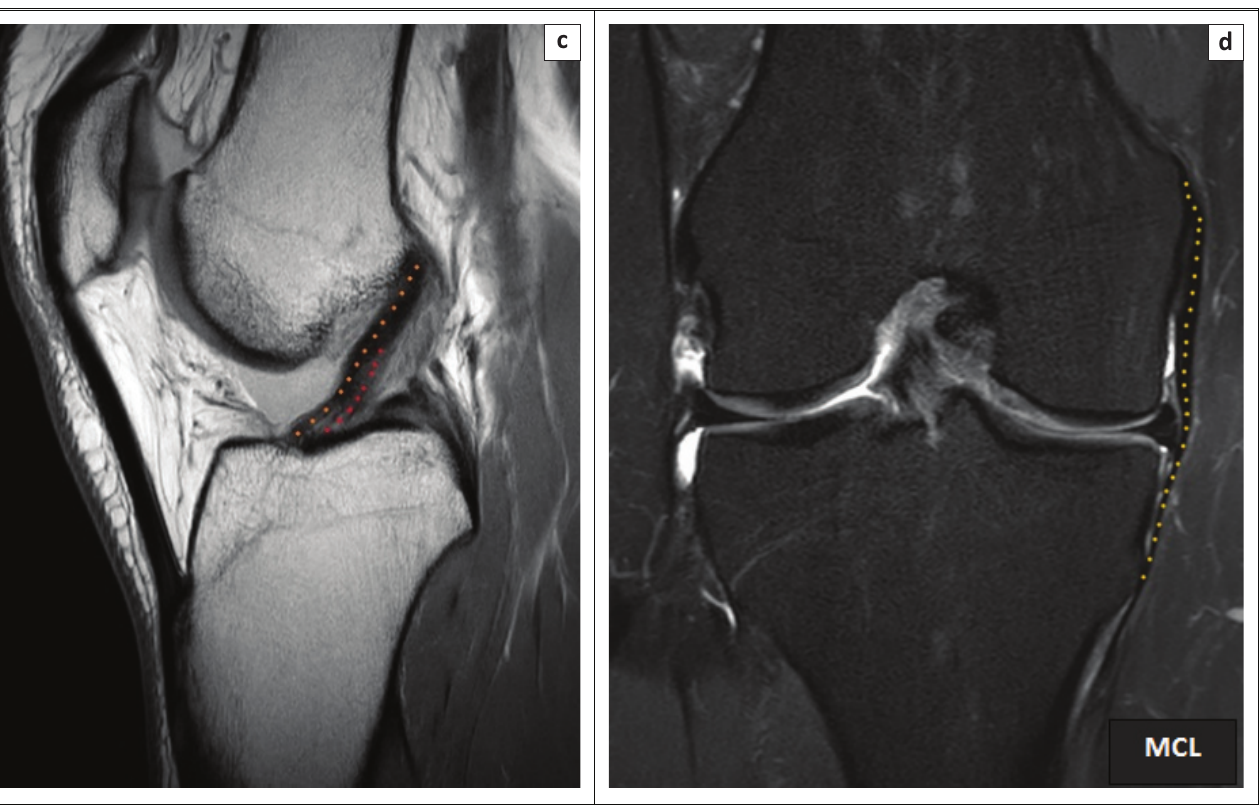
FIGURE 9 (Continues ...): Patellar dislocation: (a) Schematic depicts flexion and internal rotation of femur on fixed tibia, (b) medial patella and lateral femur condyle impactions, and (c) and (d) show anterior cruciate ligament and MCL injury respectively, which may occur with sufficient force.